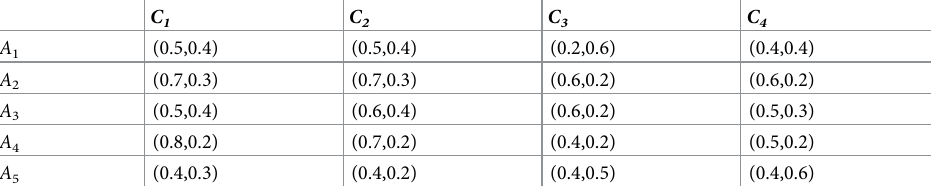
Table 1. The q -rung orthopair fuzzy decision matrix M 1 given by D 1